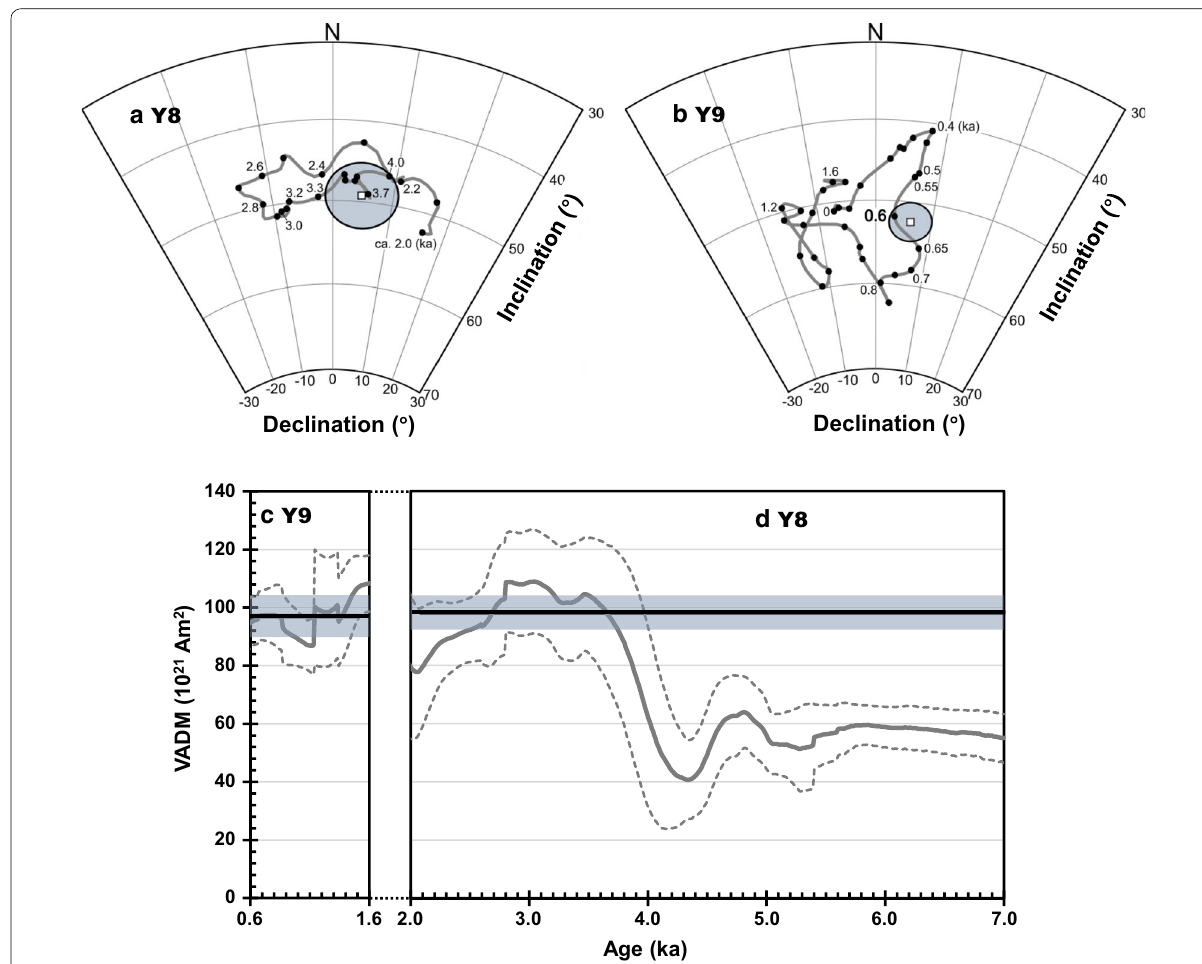
Fig. 6 PSV record during the past 4.0–2.0 ka ( a ) and 7.0–2.0 ka ( d ) for Y8 lava and 1.6–0.6 ka for Y9 lava ( b , c ) and our paleomagnetic results. Paleodirection obtained from Lake Biwa sediments (Ali et al. 1999) and that from the Japan Archeomagnetism Database (Hatakeyama and Shibuya 2012) were adopted, respectively, as PSV to paleodirection age estimation for Y8 ( a ) and Y9 ( b ) lava. Paleointensity data obtained from eastern Asia (Cai et al. 2017) were adopted as PSV for paleointensity age estimation ( c , d ). Mean paleodirections of Y8 ( a ) and Y9 ( b ) lava and their 95% confdence angles are shown, respectively, as open squares and gray circles. Estimated VADM values of Y9 ( c ) and Y8 ( d ) lava and their standard deviations are shown, respectively, as bold lines and gray